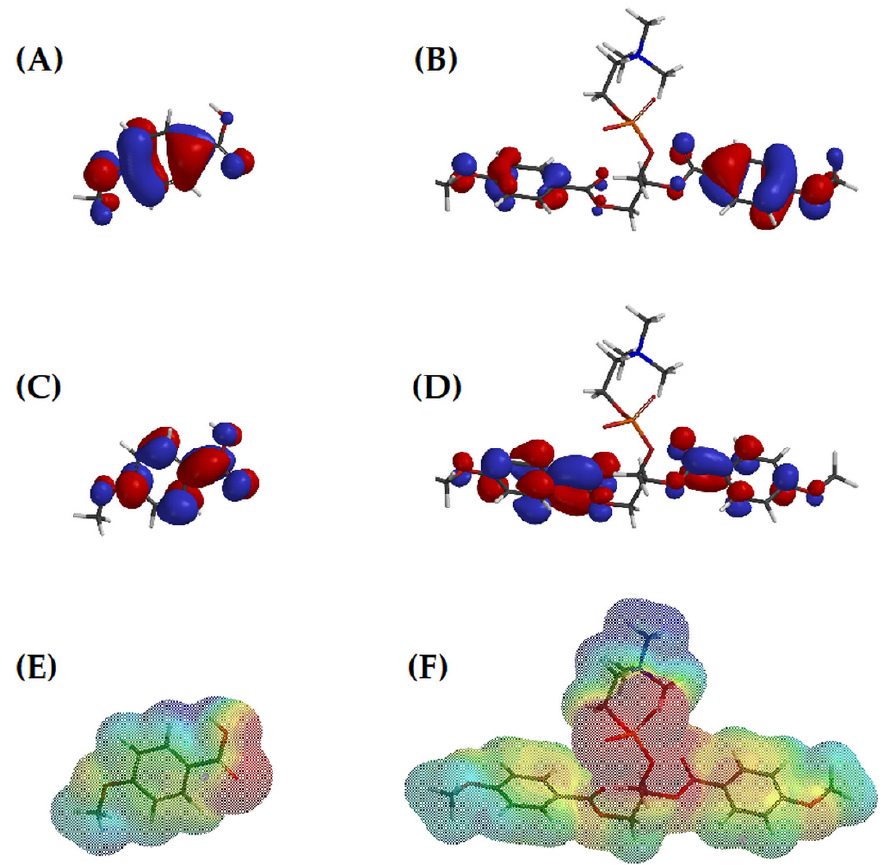
Figure 10. The spatial orientation of HOMO ( A , B ) and LUMO ( C , D ) orbitals and electrostatic potential map ( E , F ) of ANISA (1a, left column) and conjugate 3a (right column) in aqueous solution (the blue color represents the positive region and the red color represents the negative region).